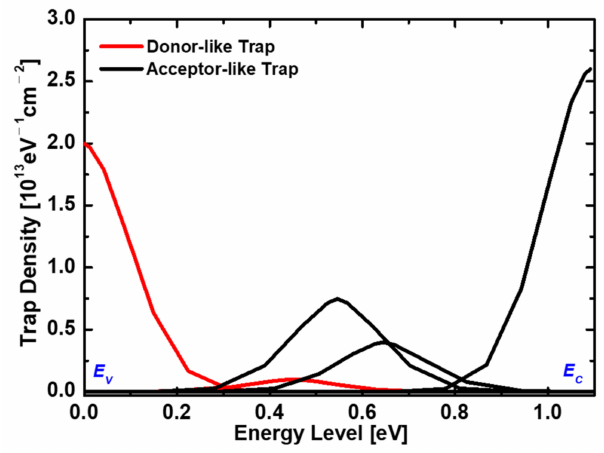
Figure 3. GB trap distribution calibrated using experimental data reported in [15].